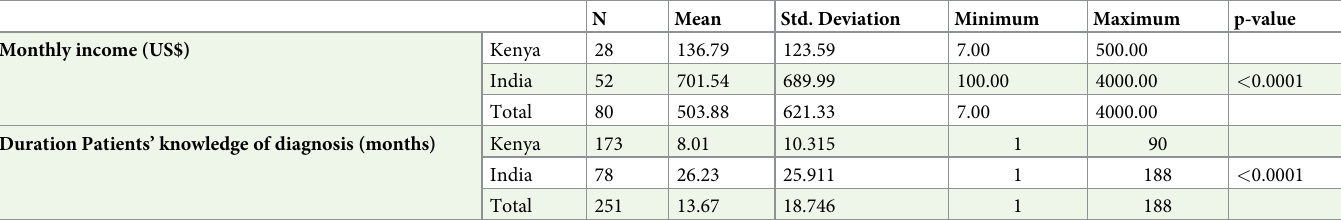
Table 4. Factors associated with choice of treatment centre: Income and knowledge of